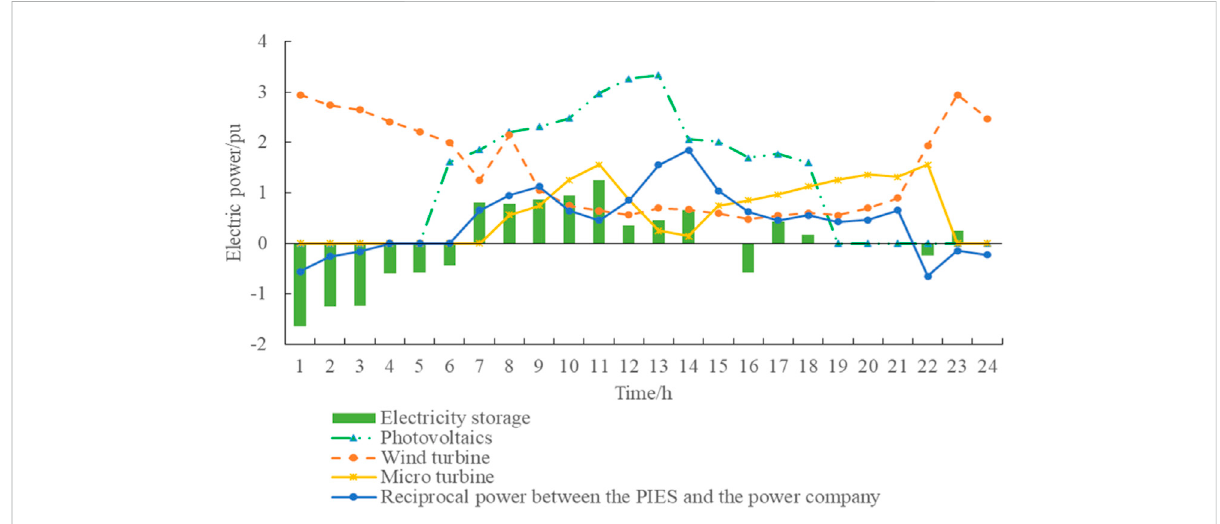
FIGURE 4 Optimization results of electricity